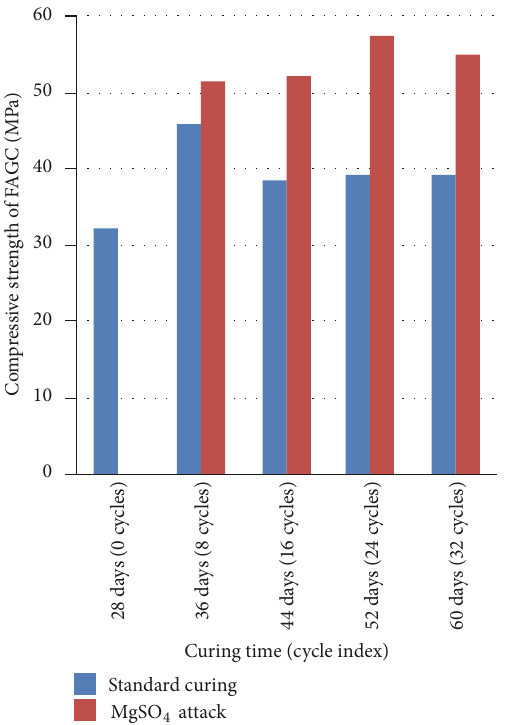
Figure 4: Compression strength evolution of FAGC in the standard curing condition and MgSO 4 attack,